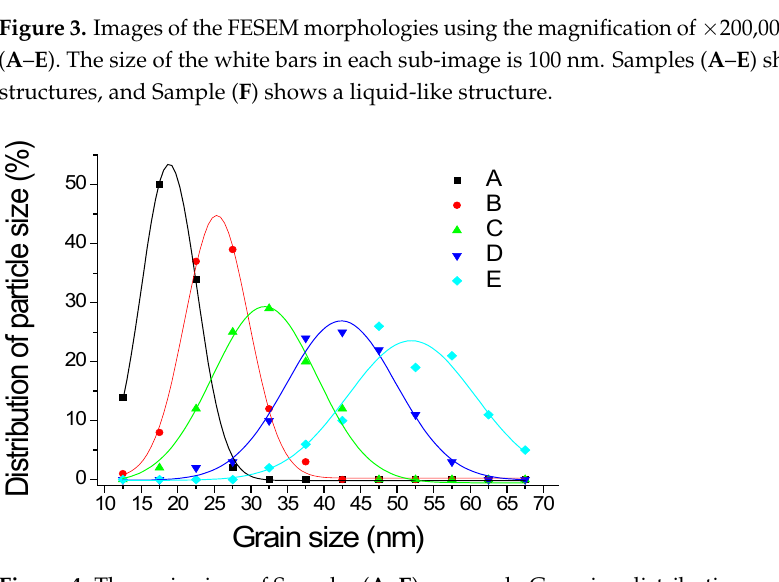
* Represented by maximum value ± FWHM/2 of Gaussian